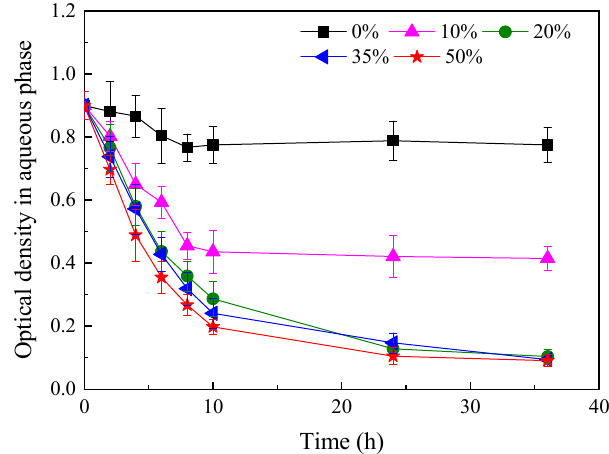
Figure 4. Time course of the variation in optical density in the aqueous phase of the biphasic system. Serum bottles (300-mL) were filled with 50 mL of a sterile mixture of silicone oil and mineral salt medium (MSM) in the absence of CB. Different volume fractions of silicone oil (0–50%) were used. 3.5. E ff ect of Silicone Oil on the Surface Characteristics of D. tsuruhatensis LW26